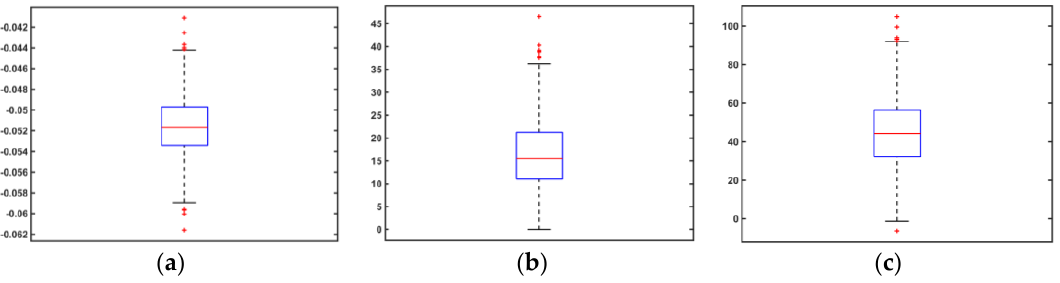
Figure 8. The box-and-whisker plots of ( a ) momentum; ( b ) sensible heat; and ( c ) latent heat fluxes retrieved from the synthetic datasets.